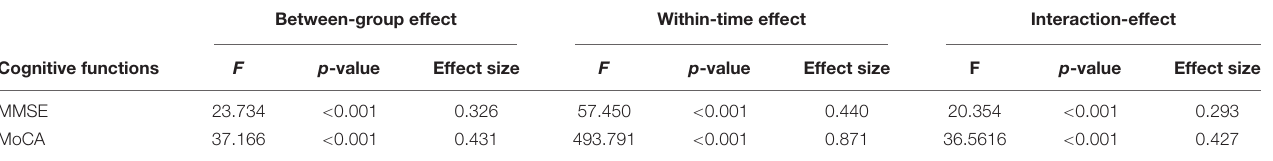
TABLE 4 | Comparison of repeated measures among the four groups.